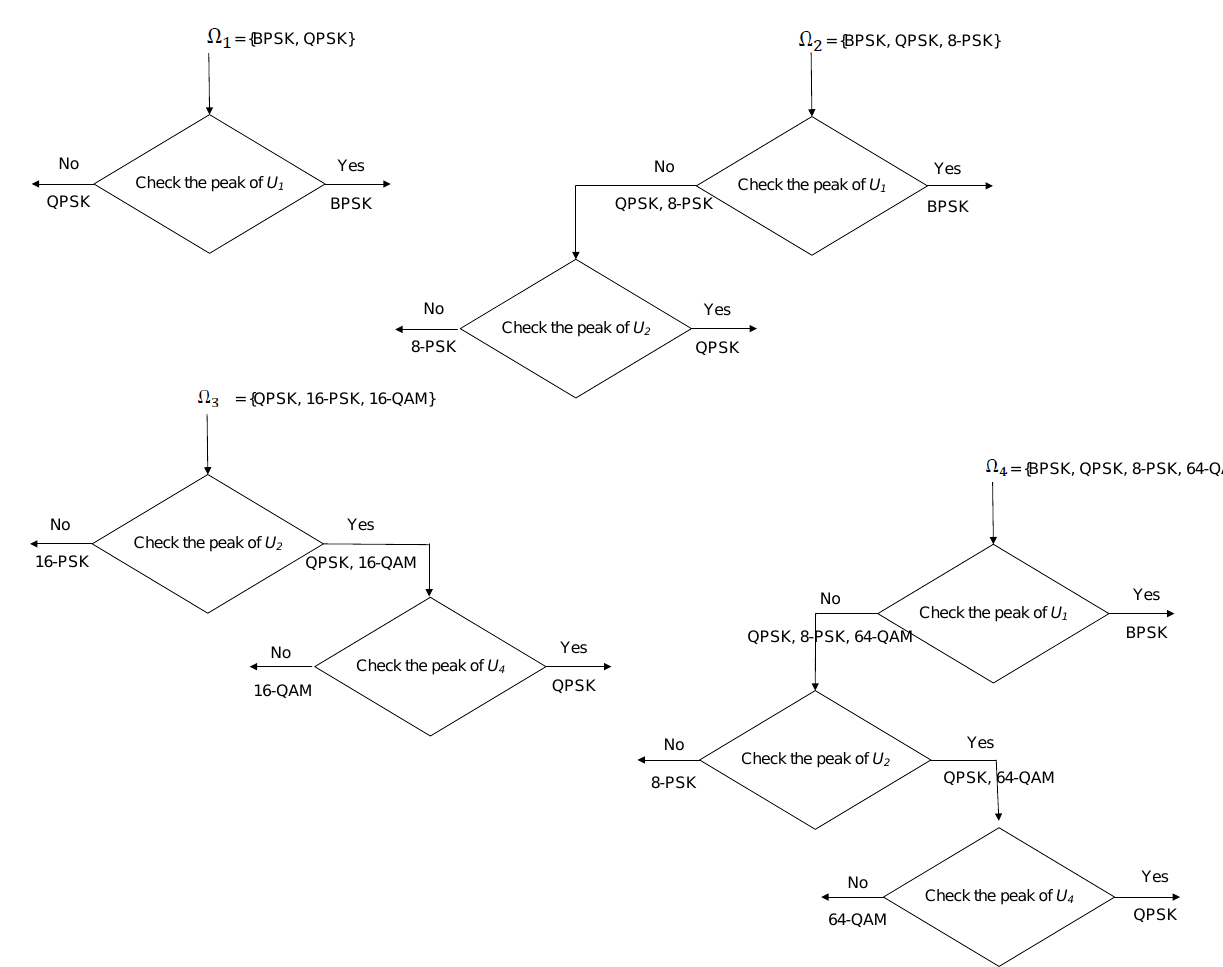
Figure 7. The flowcharts of four modulation